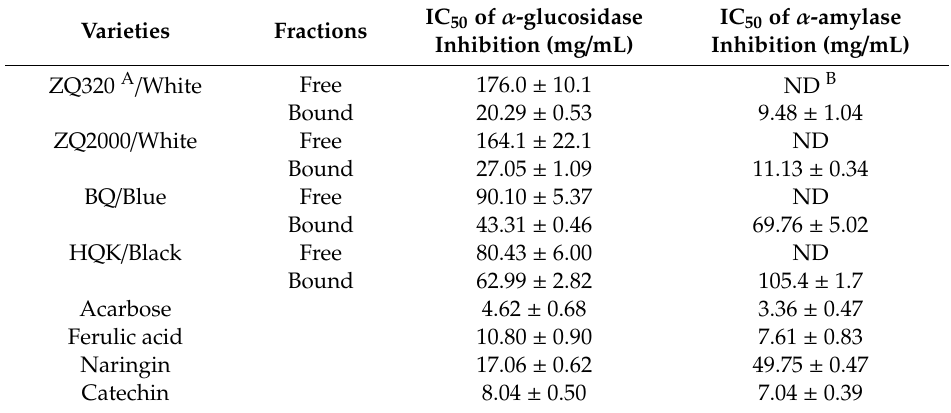
Table 3. The median inhibition dose (IC 50 ) of α -glucosidase and α -amylase inhibitions on four highland barley varieties (mean ± SD, n =